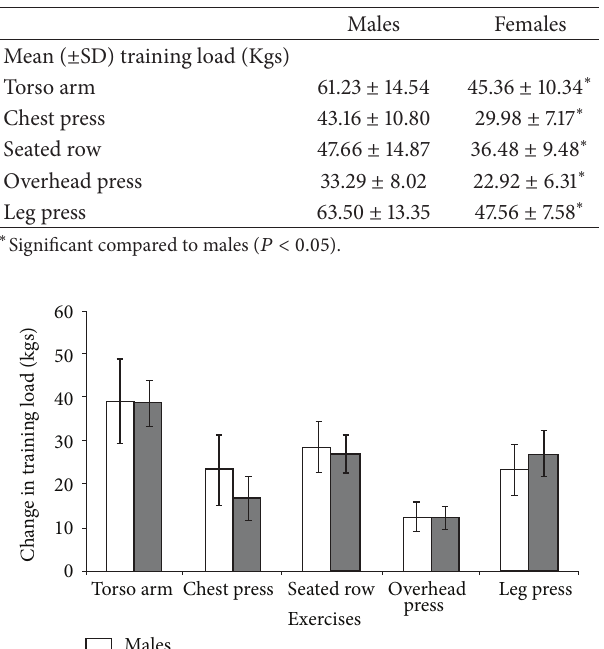
Table 3: Beginning training loads.